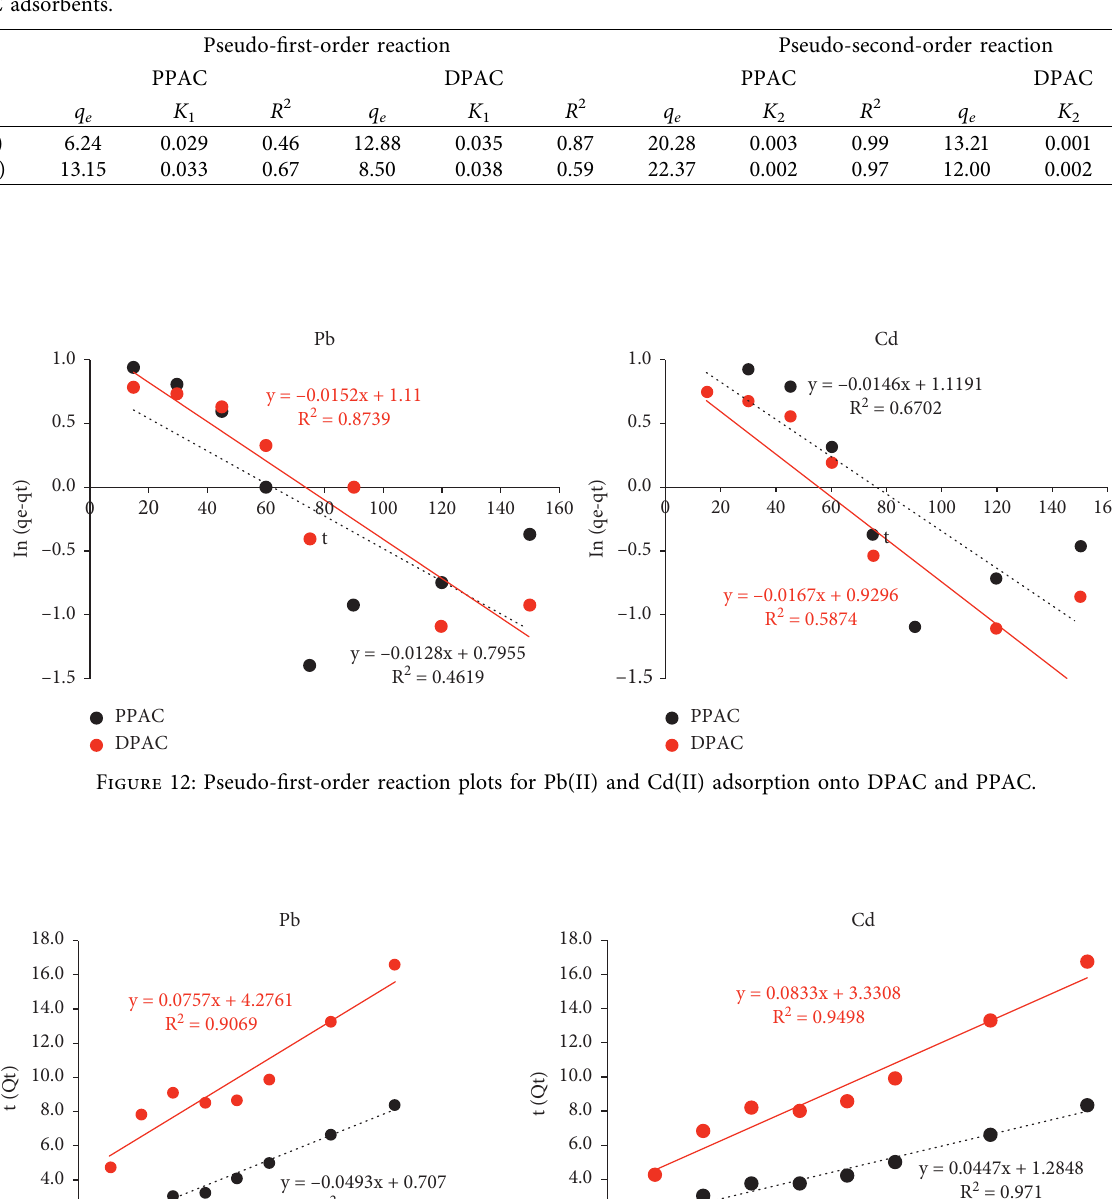
y = –0.0493x + 0.707 R 2 =